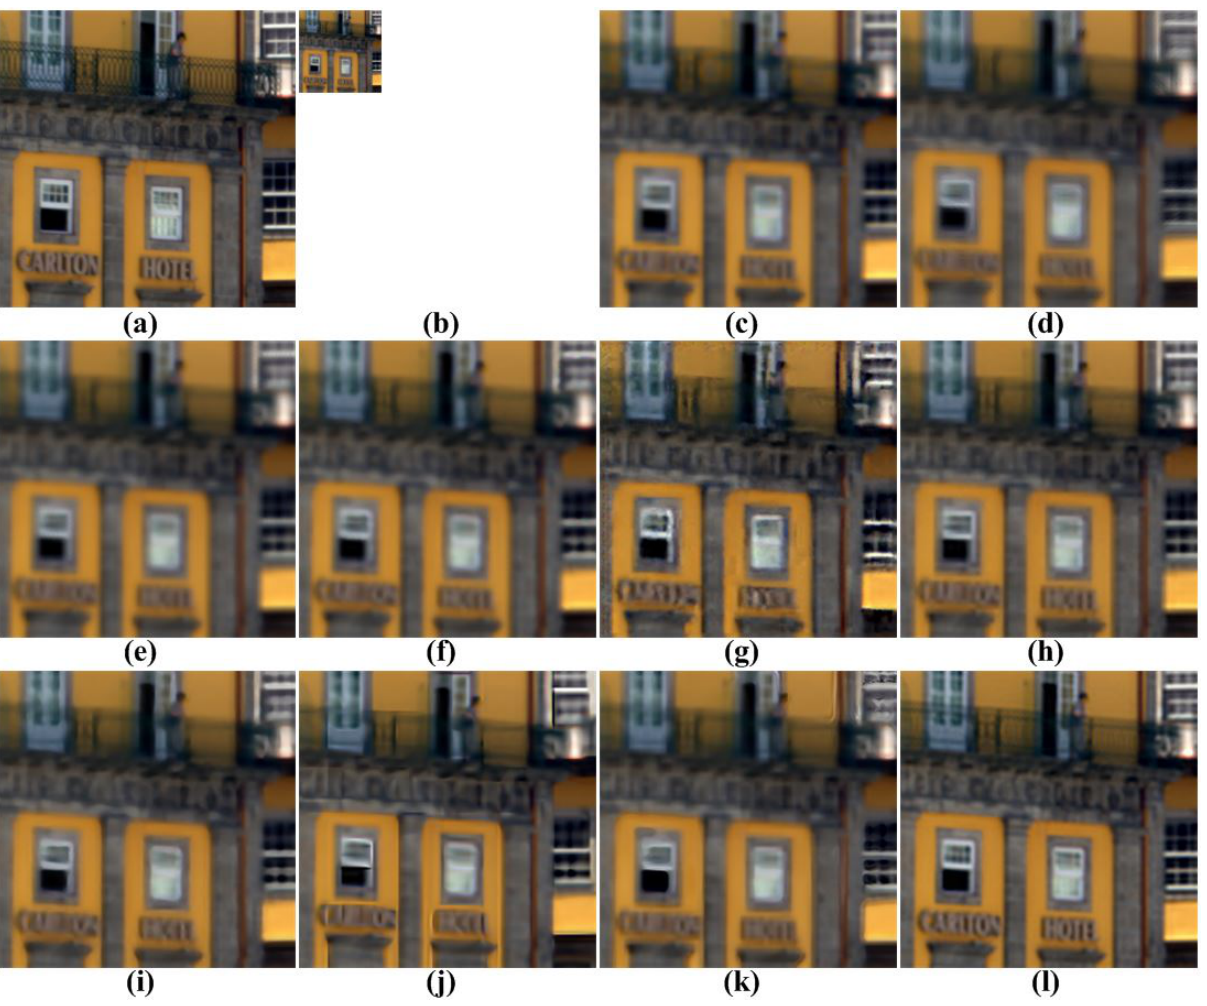
Figure 6. Results of resolution enhancement by enlarging a simulated LR multispectral image: ( a ) cropped original HR image in Figure 4b; ( b ) the four-times down-sampled LR image; results of: ( c ) cubic-spline interpolation [3], ( d ) interpolation-based SR [4], ( e ) interpolation-based SR [5], ( f ) interpolation-based SR [6], ( g ) example-based SR [7], ( h ) patch-based SR [9], ( i ) patch-based SR [10], ( j ) patch-based SR [11], ( k ) patch-based SR [12] and ( l ) the proposed